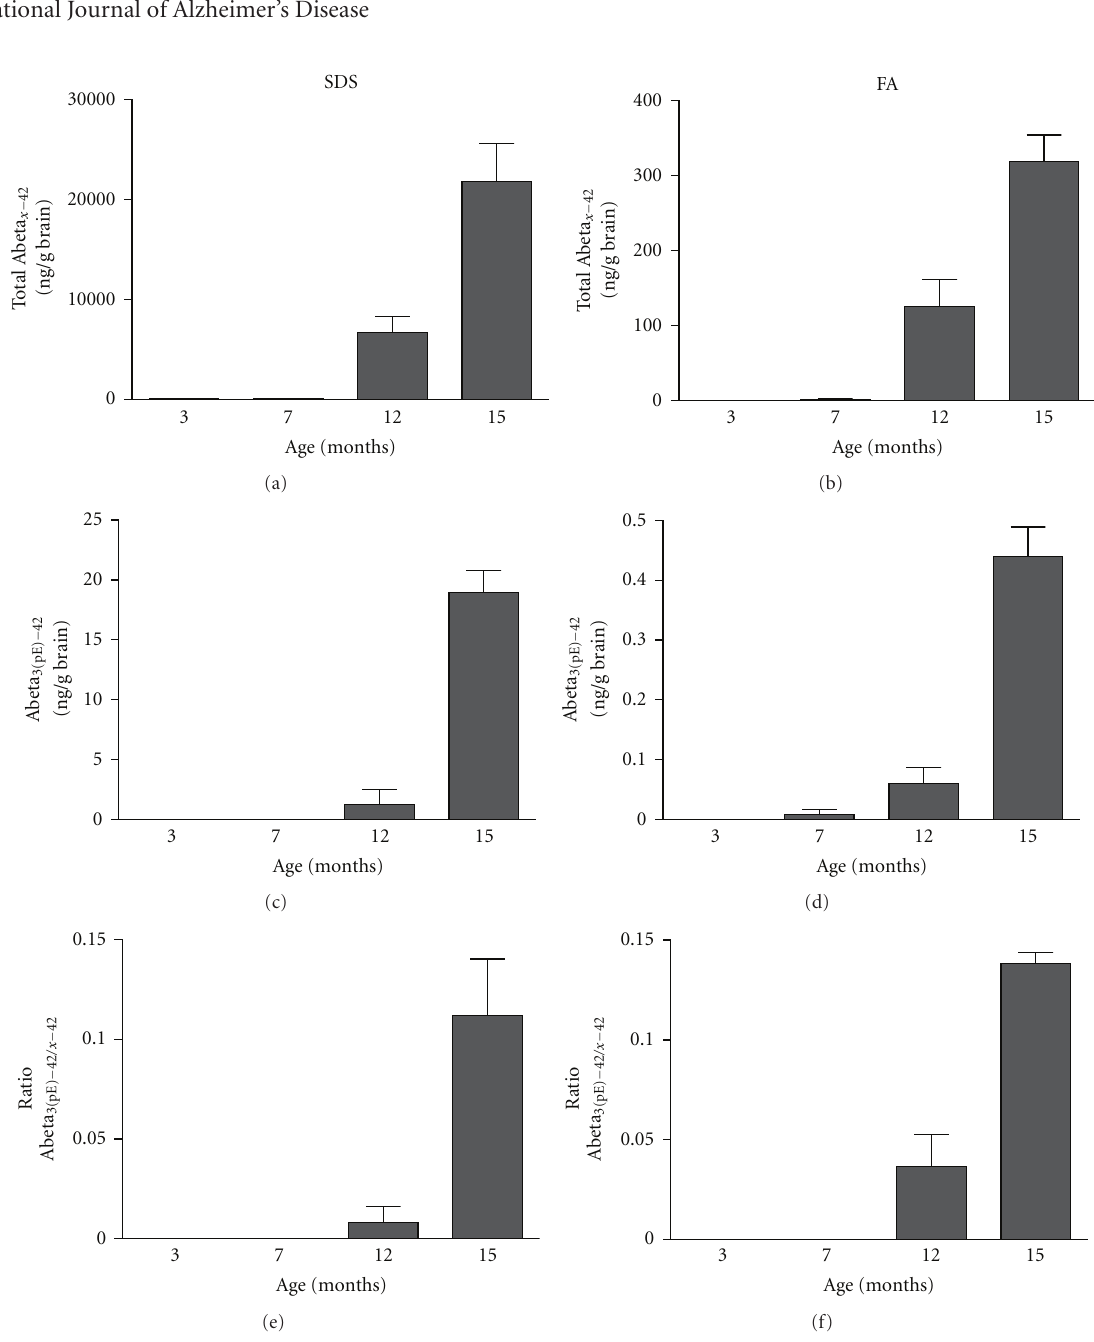
soluble oligomeric Abeta is present in brain of APP-Ld mice and their levels gradually increase with age (Figure